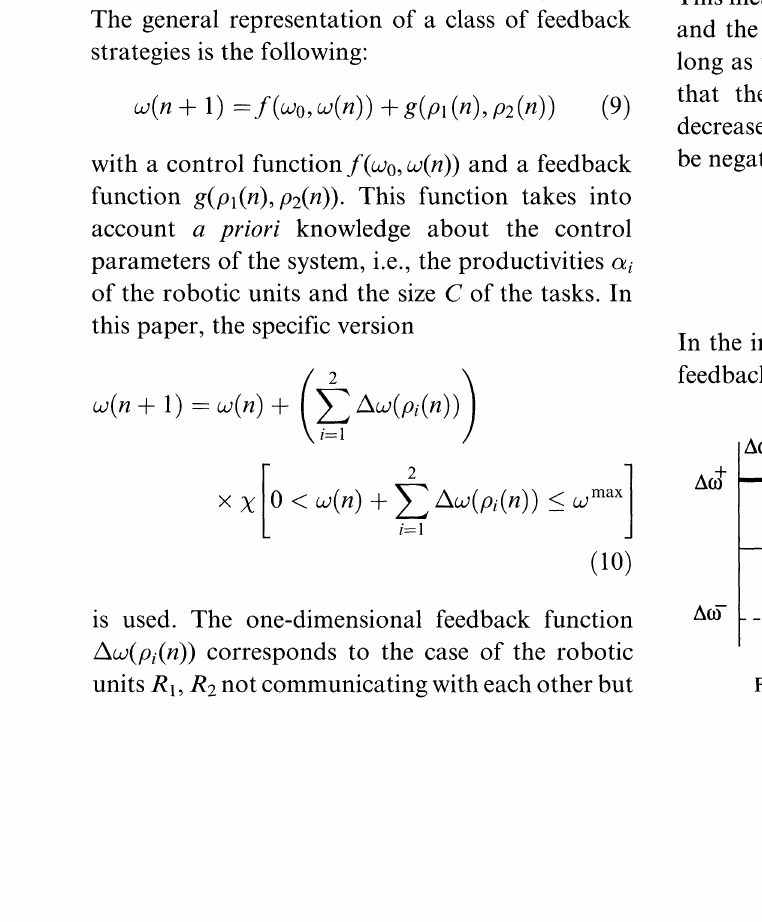
FIGURE 3 Investigated feedback